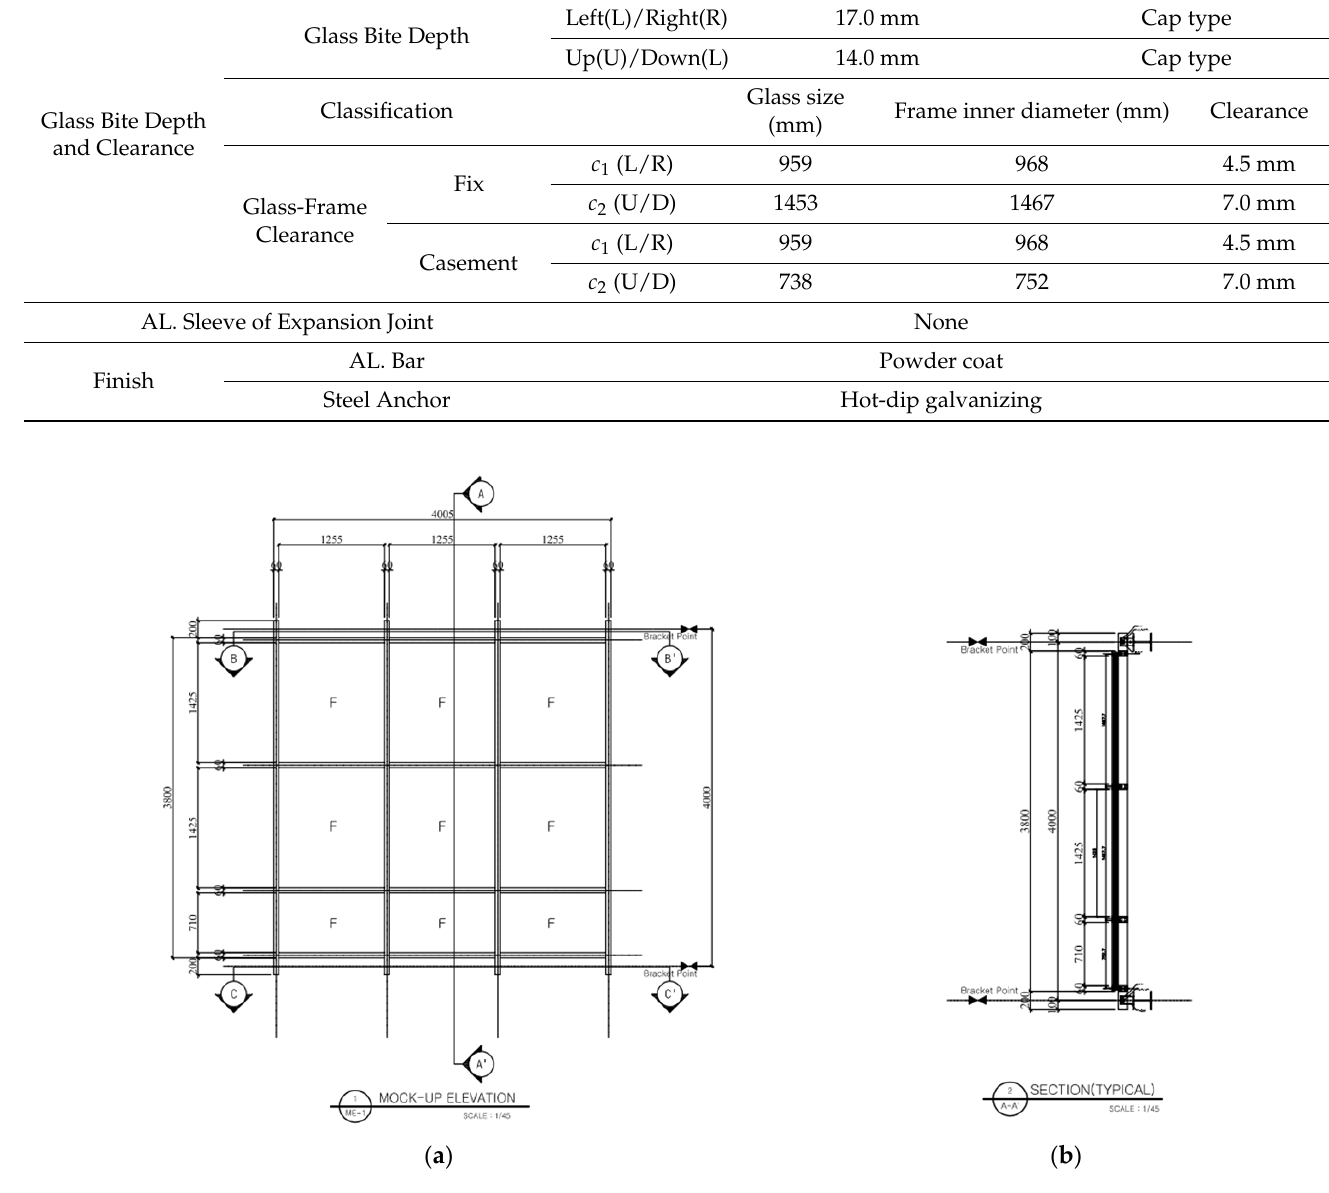
Figure 11. Seismic curtain wall specimen: ( a ) front view; ( b ) side view. Table 4. Designed member specifications of non-seismic specimen components. Table 5. Designed member specifications of seismic specimen